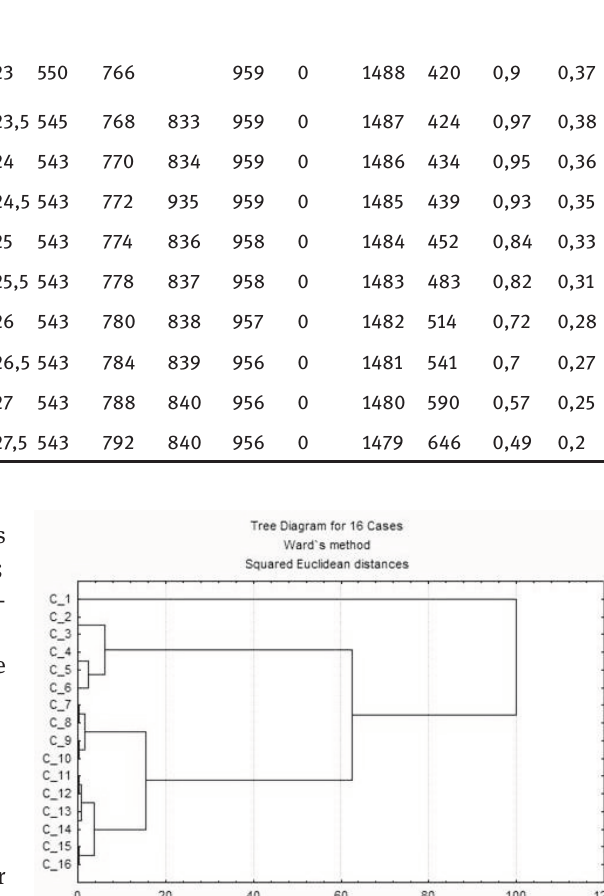
Table 1: Datasets depending on the glass composition for xMgO·(1-x)B Composition